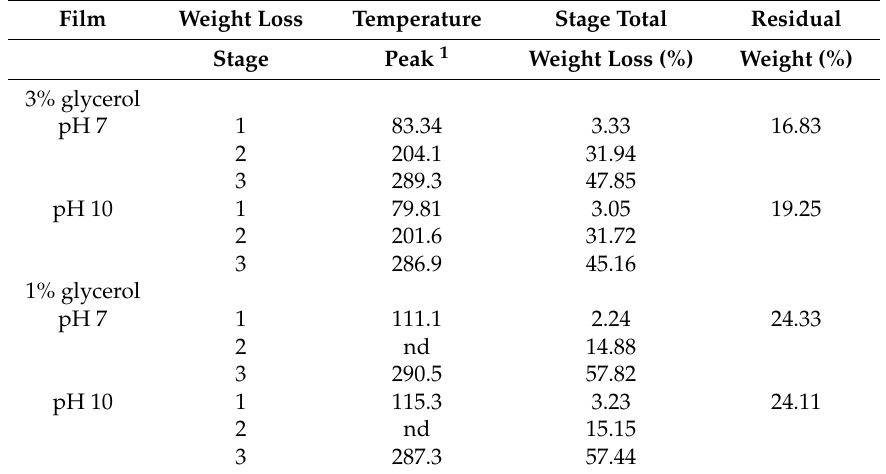
Table 5. Thermogravimetric analysis results of chickpea flour films.